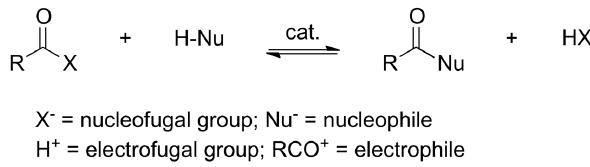
Figure 3. ( A ) Free energy diagram for an uncatalyzed reaction converting reactants A + B into product AB ; ( B ) for a reaction catalyzed by catalyst C .